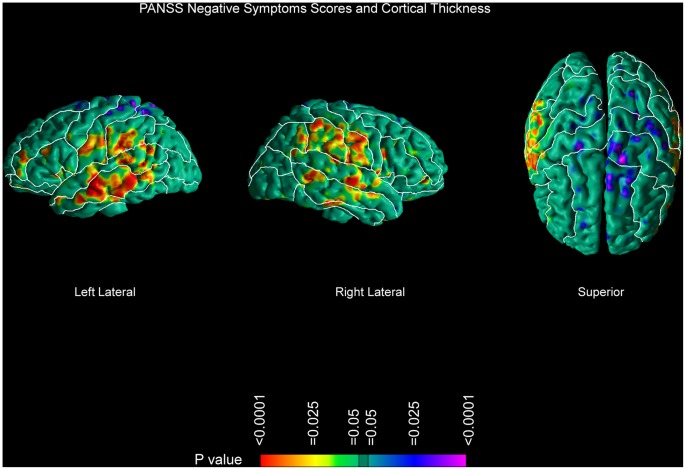
Correlations of Cortical Thickness with Severity of Negative Symptoms.Statistical effects are color-encoded as in Fig. 1. This figure shows correlations of cortical thickness measures with negative symptoms scores from the PANSS. All correlations are GRF-corrected. Increased symptom burden was associated with greater thickness in perisylvian cortices but only minimal thinning in the left superior and left precentral gyrus (compare with Fig. 2). We did not find any association of WM surface morphology with symptom scores.